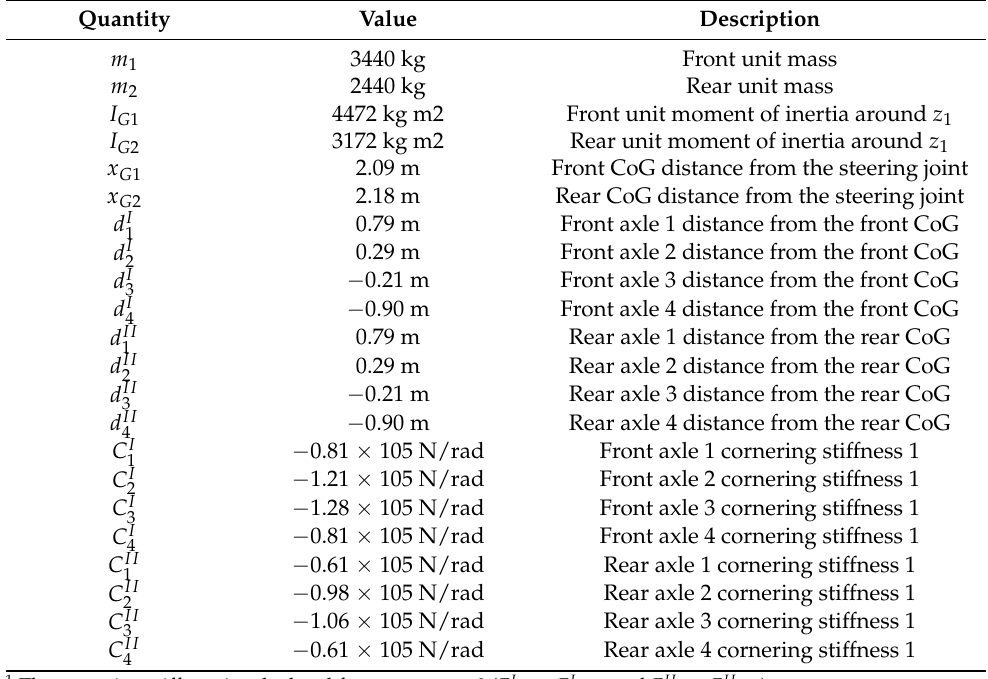
Table 1. ATV linearized model parameters.